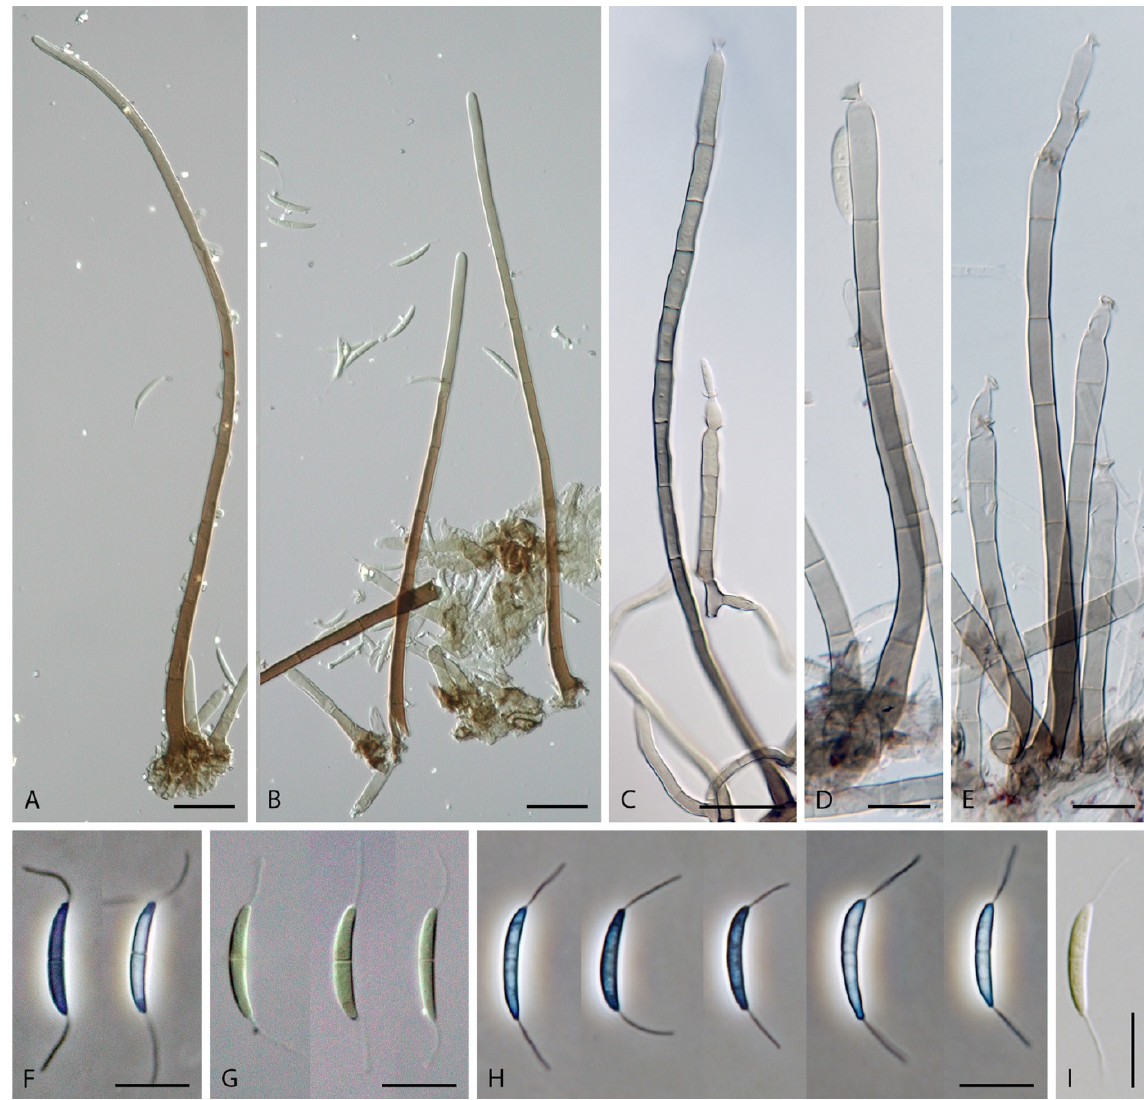
Figure 42. Stilbochaeta septata (CBS 146716). ( A – E ) Setae with conidiophores ( F – I ) conidia. Images: ( A , B , F , G ) from nature ( C , H , I ) on PCA after 4 weeks ( D , E ) on OA after 4 weeks. Scale bars: ( A – C ) 20 μ m; ( D – I ) 10 μ m.